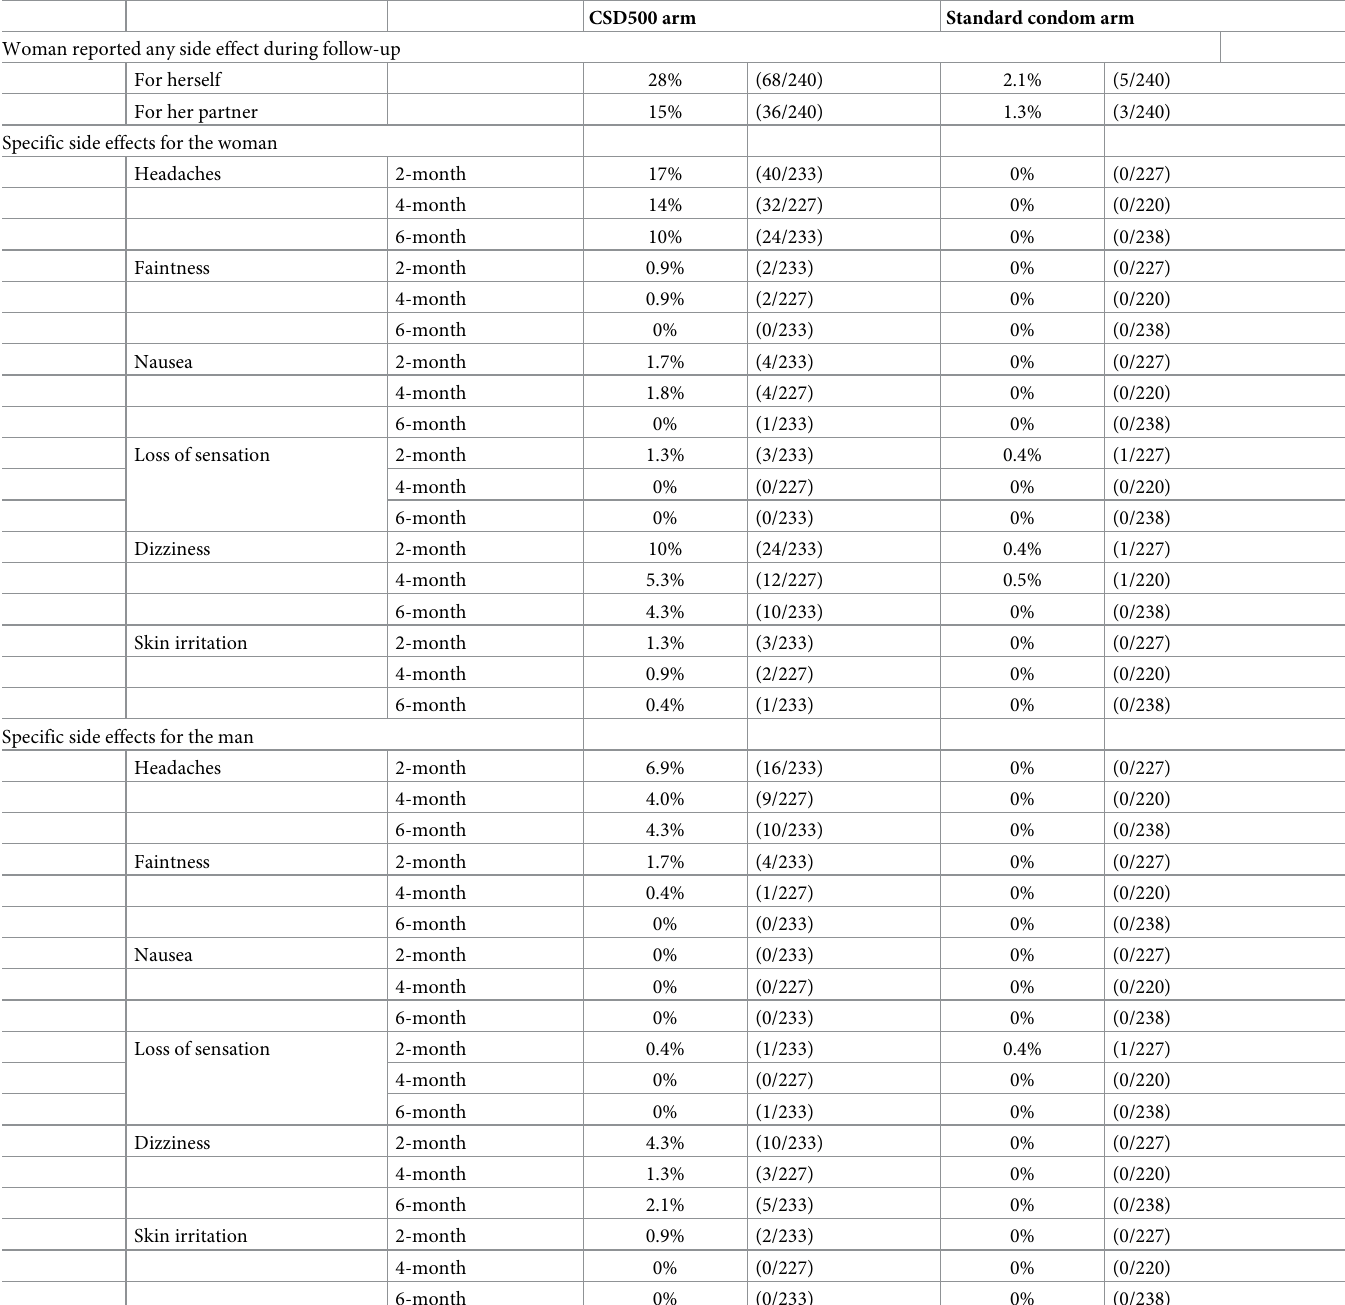
Table 4. Side effects reported by female participants during the follow-up period by study